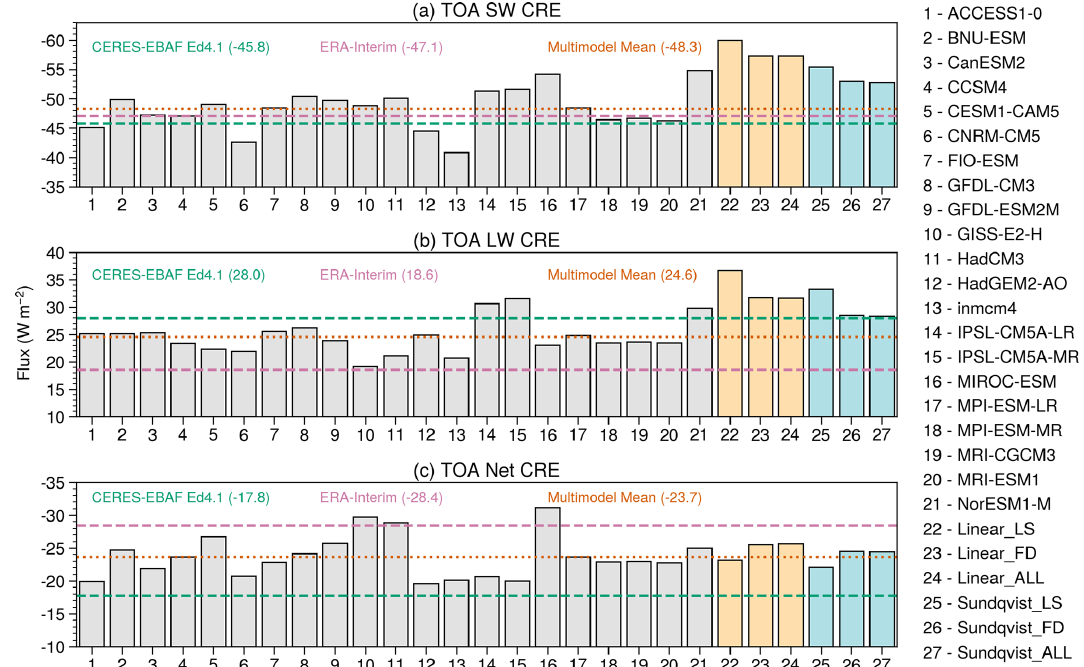
Figure 17. Globally averaged TOA (a) shortwave (SW), (b) longwave (LW) and (c) net cloud radiative effects (CREs, Wm − 2 ) from 21 CMIP5 models historical runs (1996–2005, gray bars) and Isca simulations with different setups (orange bars for linear scheme and cyan bars for Sundqvist scheme). The horizontal lines are annual and global mean CREs from CERES-EBAF (dashed green lines, covering from 2001 to 2018) and the multimodel ensemble mean results (dotted orange lines) of CMIP5 models, whose names are listed on the right for